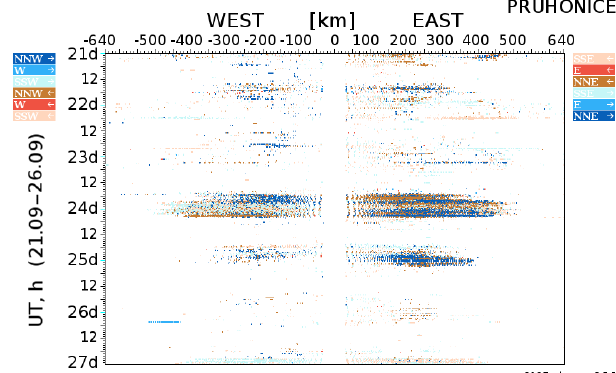
Figure 9. Directogram – direction of plasma motion above the ob- servation site – recorded on 21–26 September presented in a stan- dard DPS-4D format. Due to the geometry of the receiving antenna field, DPS-4D identifies the direction of the wave arrival. The direc- tograms are constructed from the raw ionograms. Each color corre- sponds to a particular antenna beam, hence the direction of the ar- rival of an oblique echo from large-scale irregularities. It is denoted by a particular color on the left- and right-hand sides of the diagram.